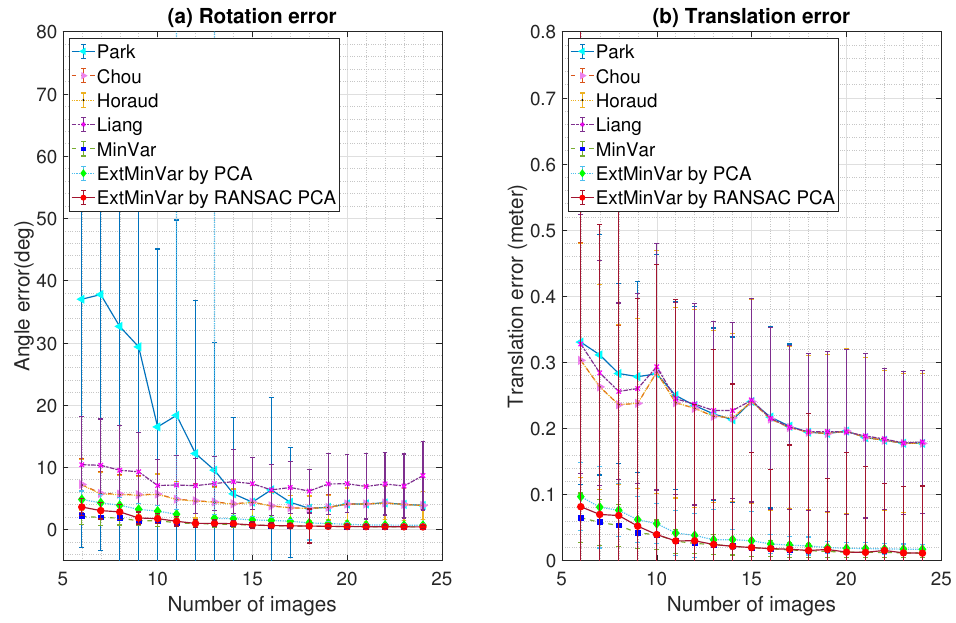
Figure 10. Stability of the estimated transformation with respect to the number of input images (feature noise: 0.5 pixel): ( a ) Rotation error; ( b ) Translation error.